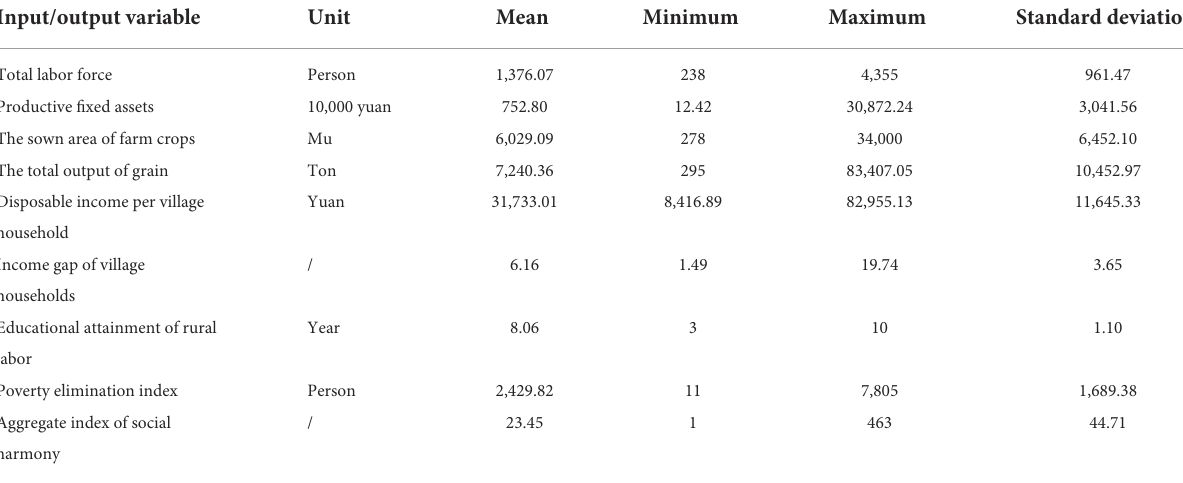
TABLE 1 Descriptive statistics of input and output variables.